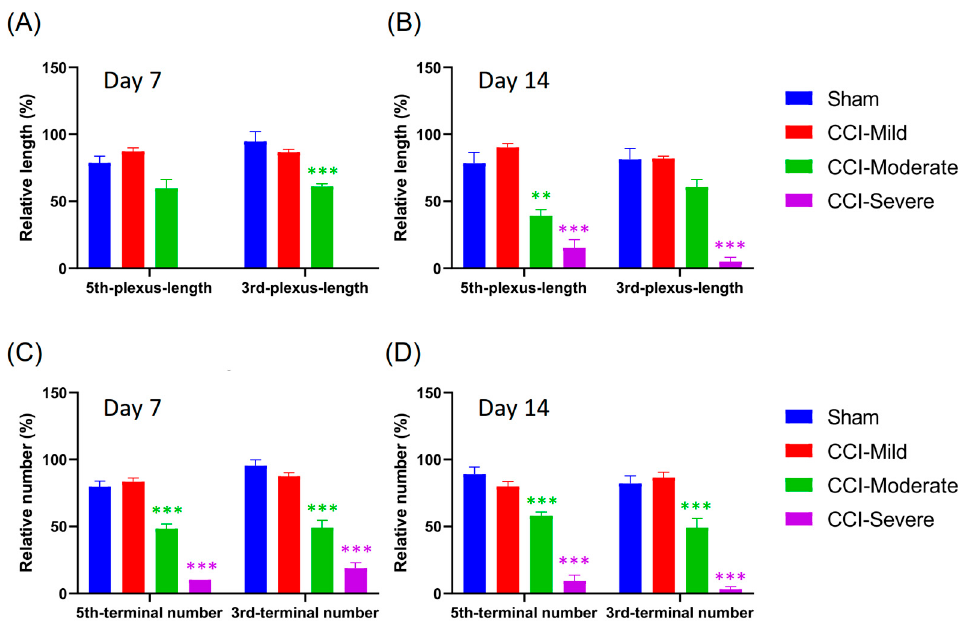
Figure 7. Small-ROI analysis of free nerve endings and sub-epidermal nerve plexus changes in the third and fifth toe tips of mice in the CCI subgroups and the sham group. The CCI-treated mice were recategorized into three subgroups according to the relative length and number of their remaining nerves: CCI-mild, 70–99%; CCI-moderate, 30–69%; and CCI-severe, 0–29%. ( A , B ) Changes in the relative length of the nerve plexus. The CCI-moderate group showed significantly reduced plexus lengths in the third and the fifth toe tips at 7 and 14 d, respectively. The CCI-severe group showed significantly reduced plexus lengths in the tips of both toes at 14 d after CCI surgery. ( C , D ) Both the CCI-moderate and the CCI-severe groups showed significantly reduced terminal numbers in the third and fifth toes tips at 7 and 14 d after CCI surgery. ** p < 0.01 and *** p < 0.001, compared to the sham group.